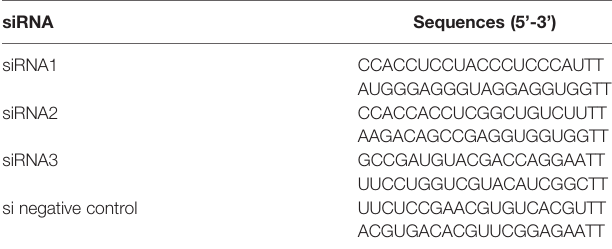
TABLE 3 | The sequences of siRNAs for